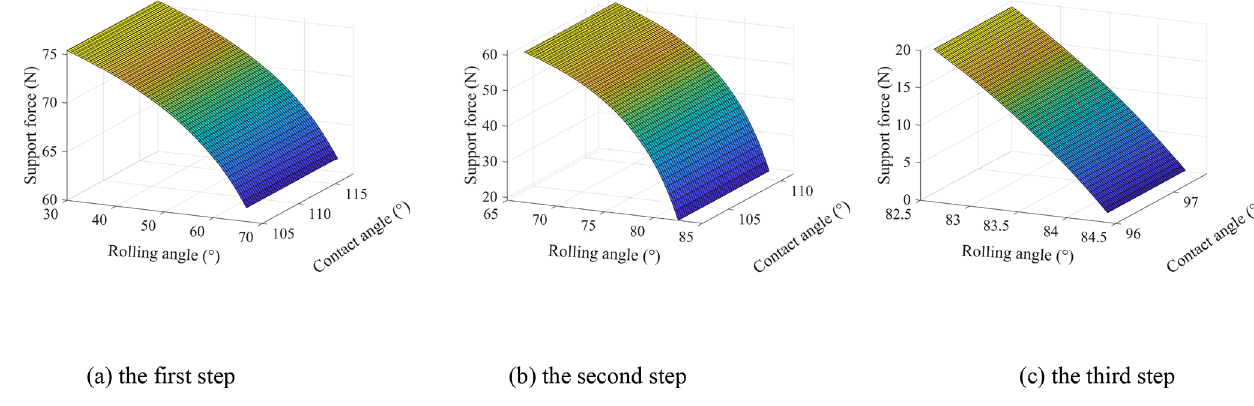
Figure 12. The variation of support force acting on support leg.